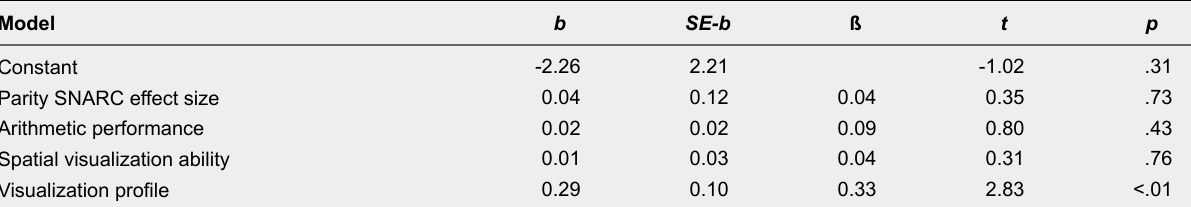
Multiple Linear Regression Analysis on the Magnitude SNARC Effect